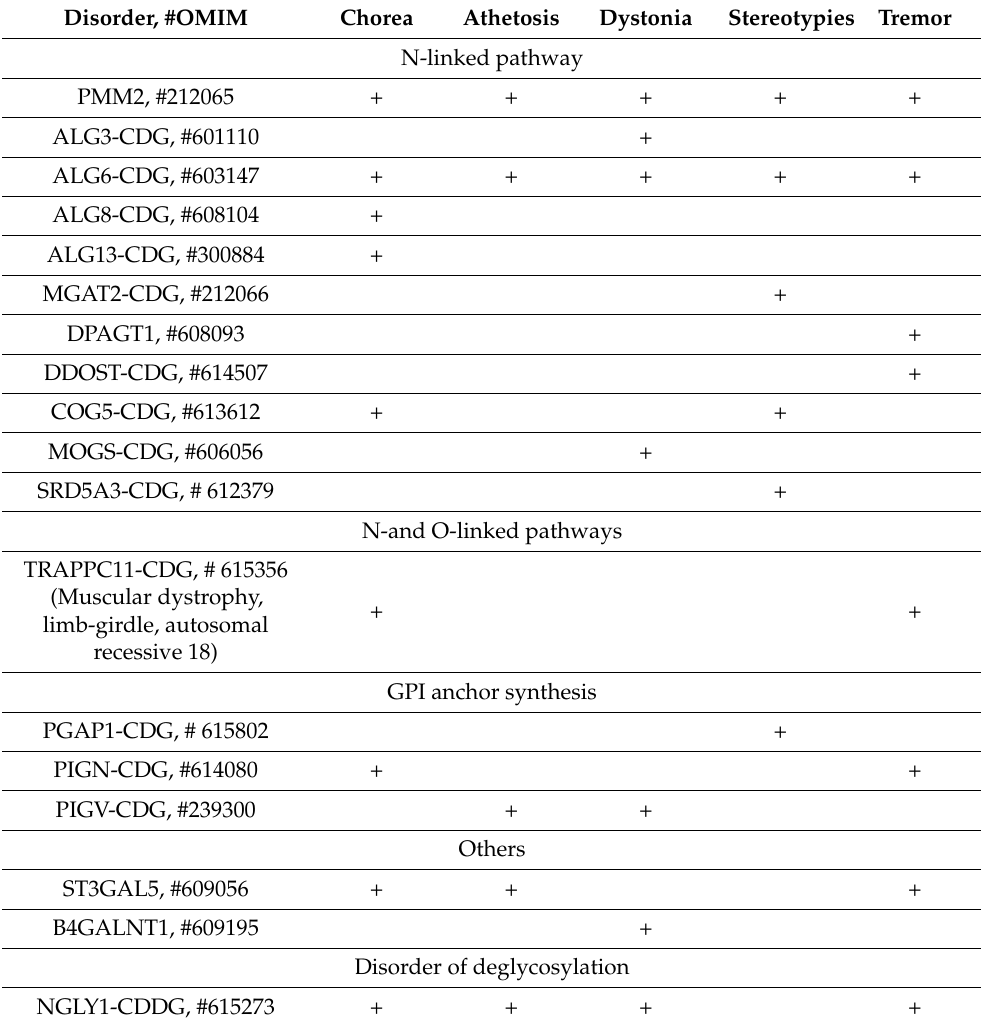
Table 4. Hyperkinetic movement disorders in CDG (the names of the diseases are given following the Online Mendelian Inheritance in Man ® , OMIM nomenclature)